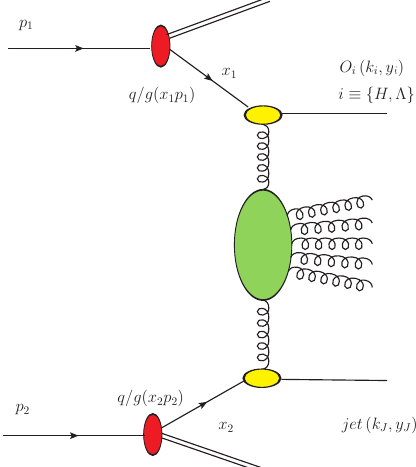
Figure 1: Schematic representation of our considered semi-hard processes.